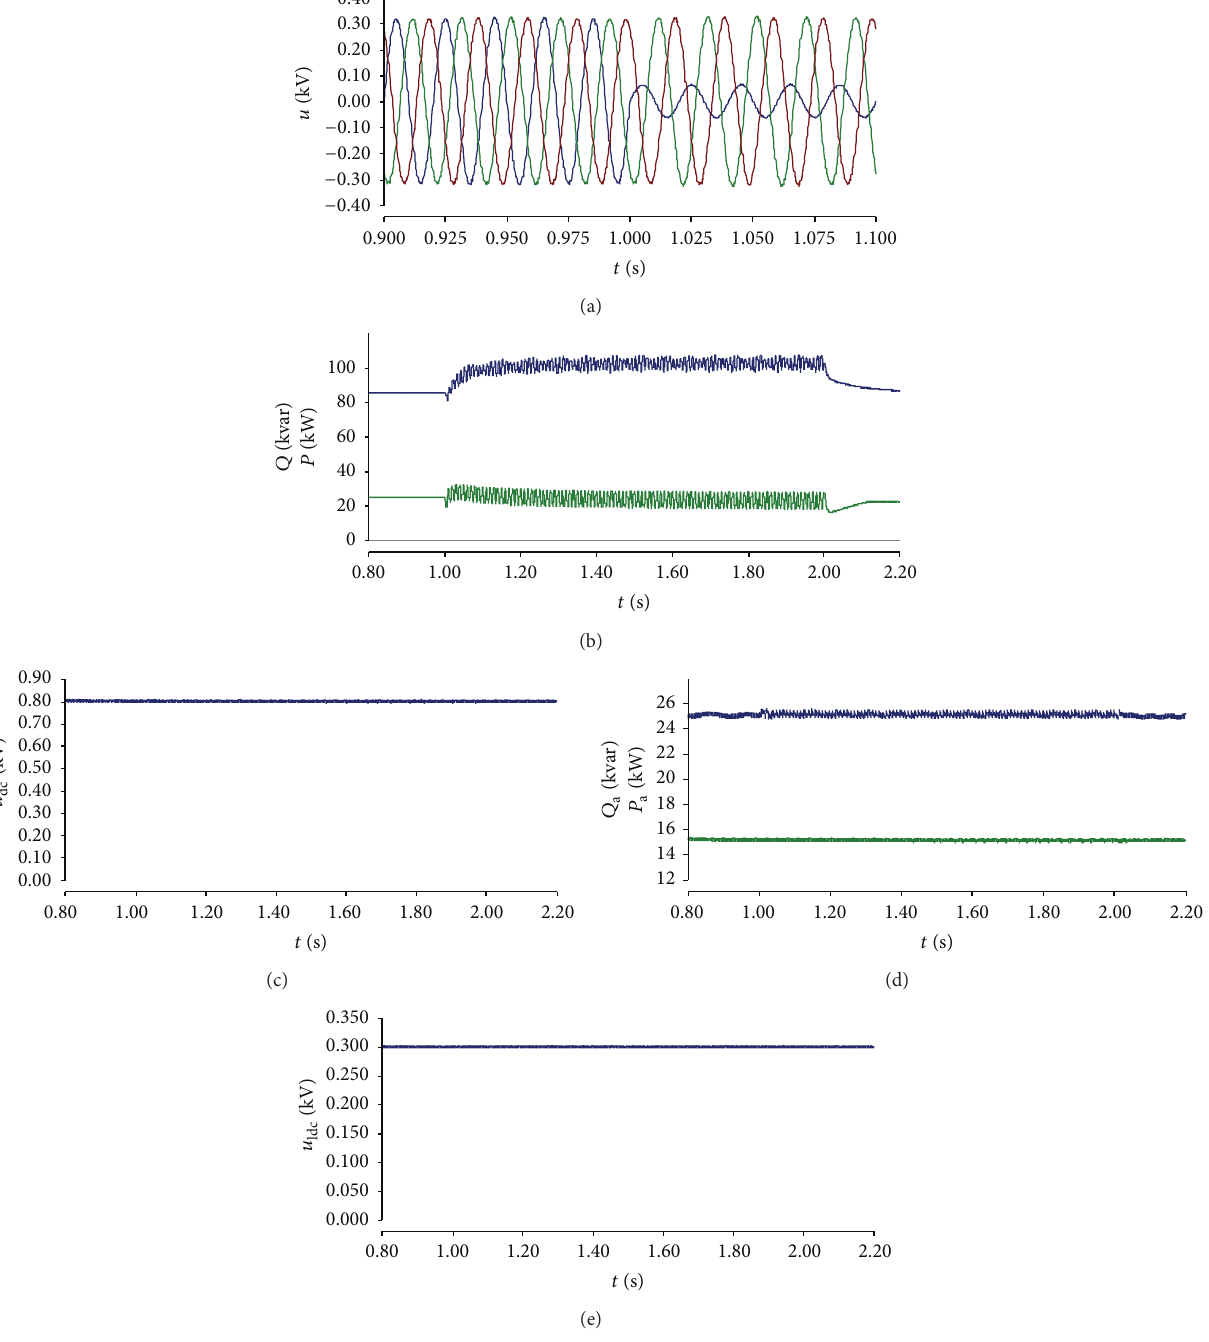
Figure 7: (a) Microgrid main feeder voltage waveform under single-phase ground fault in distribution network. (b) Microgrid exporting power waveform under single-phase ground fault in distribution network. (c) DC bus voltage waveform of sub-microgrid A under single- phase ground fault in distribution network. (d) AC load power waveform of sub-microgrid A under single-phase ground fault in distribution network. (e) DC load voltage waveform of sub-microgrid A under single-phase ground fault in distribution